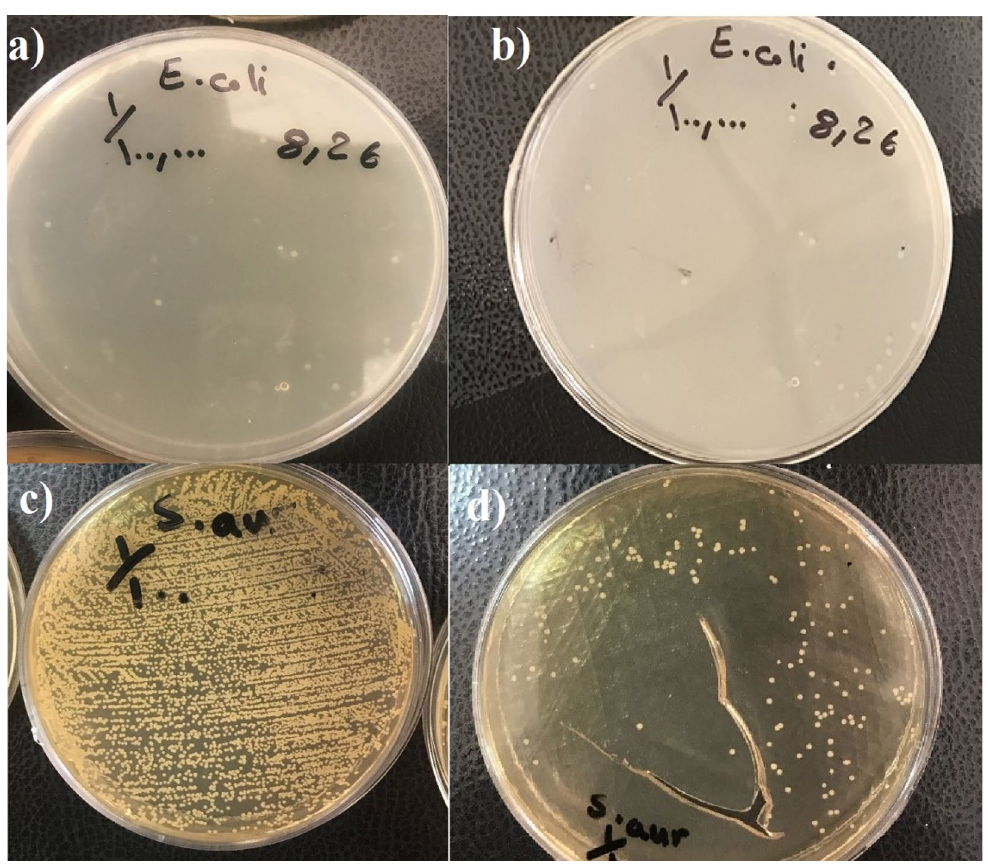
Figure 6. Bacteria growth after exposure to the scaffolds: ( a ) and ( b ) E. coli , ( c ) and ( d ) S. aureus after treatment with Gel-BG ( a , c ) and Gel-BG/sr ( b , d )